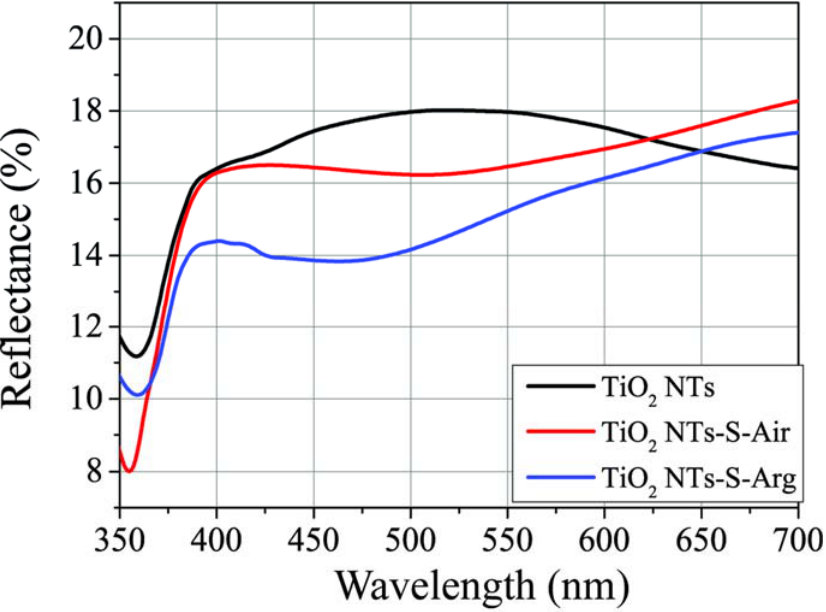
Figure 2. Diffuse light reflection spectra for different types of samples.